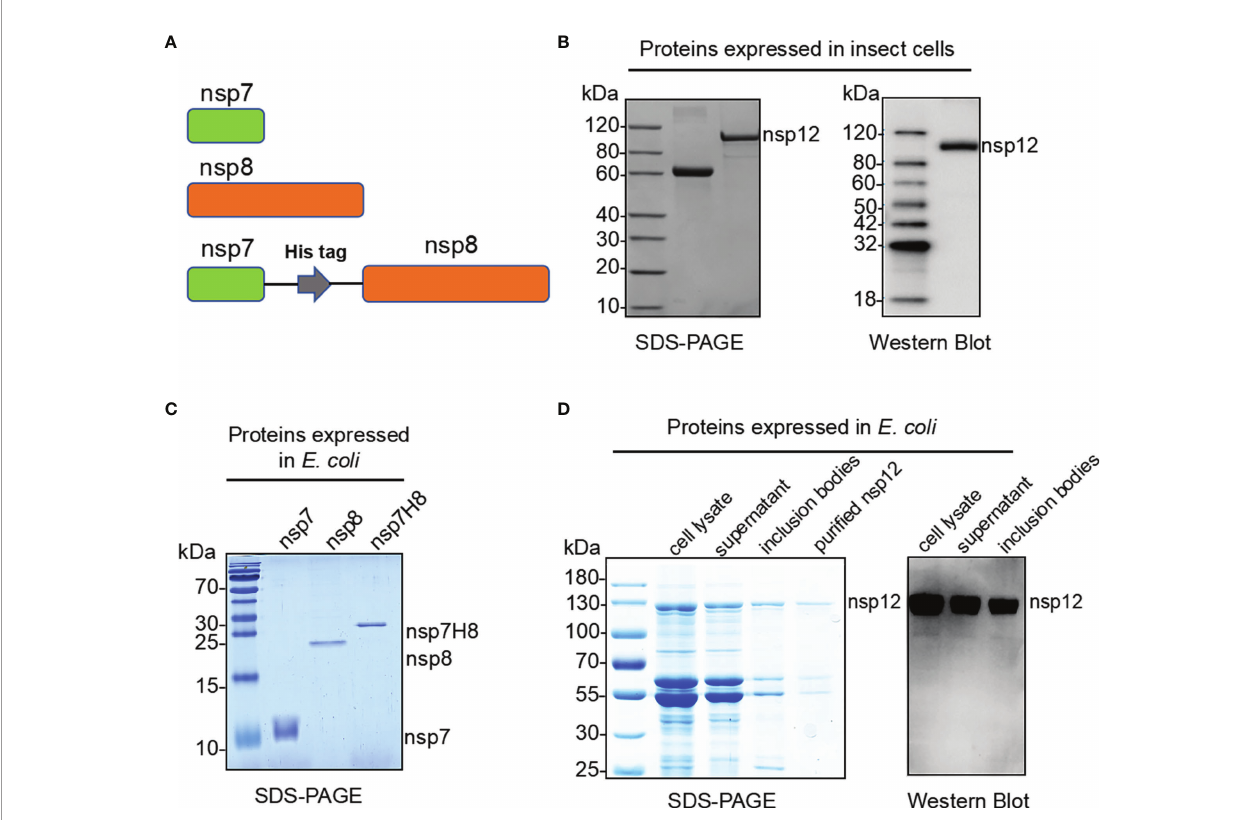
FIGURE 1 | Expression and puri fi cation of the SARS-CoV-2 RdRp complex. (A) Schematic diagram for the components of the RdRp complex, containing nsp7, nsp8, and nsp7-His 6 -nsp8 (nsp7H8). (B) Puri fi ed SARS-CoV-2 nsp12 proteins expressed in baculovirus-infected insect cells (Sf9) were analyzed by SDS-PAGE and Western blot. (C) Bacterially expressed and puri fi ed SARS-CoV-2 nsp7, nsp8, and nsp7H8 proteins were analyzed by SDS-PAGE. (D) Bacterially expressed and puri fi ed SARS-CoV-2 nsp12 protein was analyzed by SDS-PAGE and Western